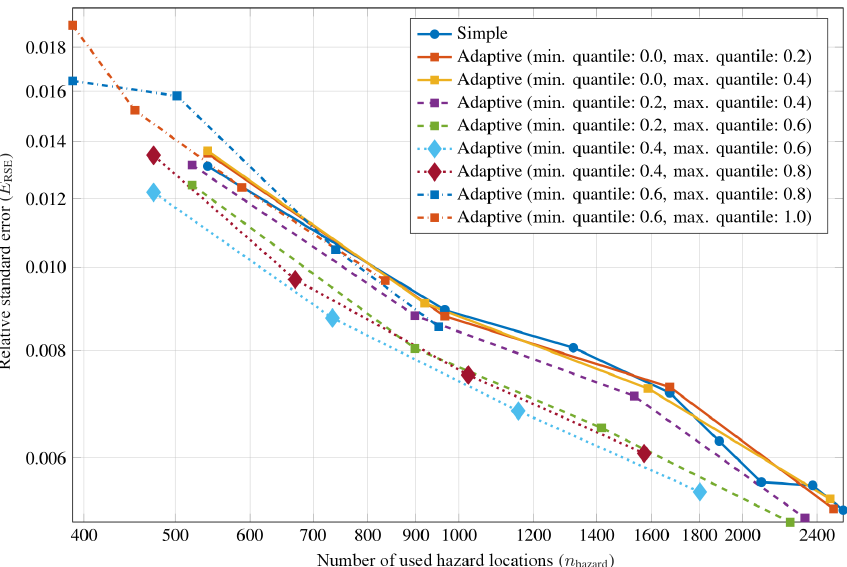
Figure 12. Results of a systematic parameter study with the goal of finding good values for the lower threshold ( t l ) and upper threshold ( t u ) parameters of criterion I of the adaptive location uncertainty sampling scheme (see Sect. 4), based on the distribution of the coefficient of variation (CV) of loss rate in administrative zones. This shows a logarithmic plot of relative standard error ( E RSE ) of probable maximum loss (PML) at a return period of 100 years against the number of used hazard locations ( n hazard ) for a portfolio of 20 risk items with 100% unknown coordinates. Color indicates different combinations for the threshold parameters t l and t u . Quantiles of the CV distribution around t l ∈ [ CV 0 . 2 ; CV 0 . 4 ] in combination with t u ∈ [ CV 0 . 6 ; CV 0 . 8 ] work